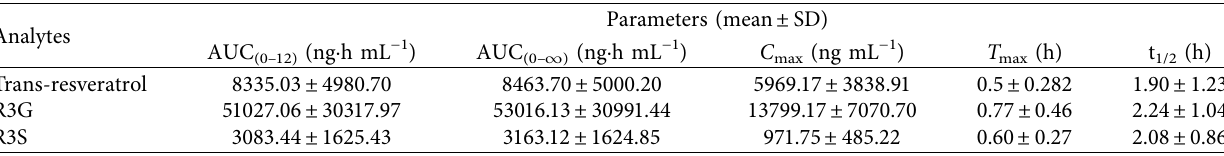
Table 5: Pharmacokinetic parameters of trans-resveratrol and its metabolites in mice after a single intragastric administration of trans- resveratrol at a dosage of 150mg kg -1 ( n � 6).